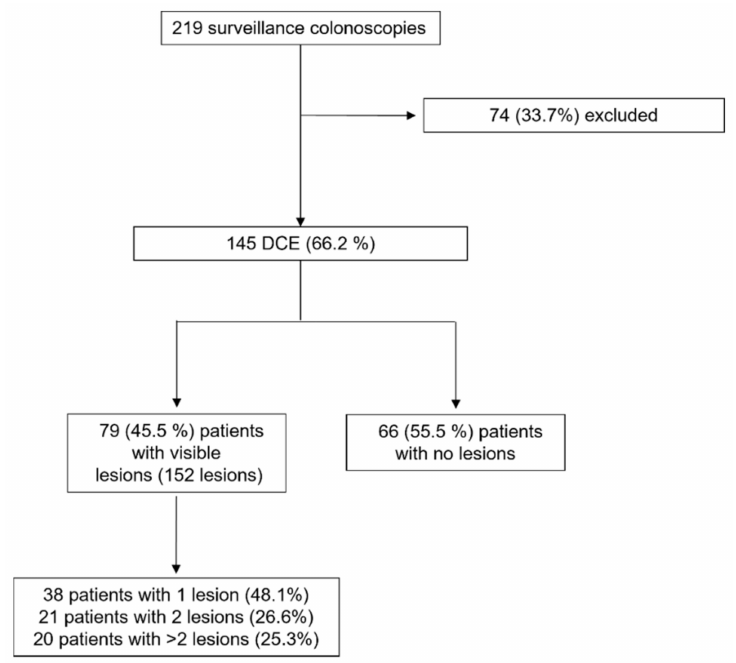
Figure 1. Flow-chart of patients with long-standing colonic IBD or concomitant primary sclerosing cholangitis undergoing surveillance colonoscopy. Table 1. Demographic and clinical characteristics of 145 patients who underwent chromoendoscopy. Characteristics of